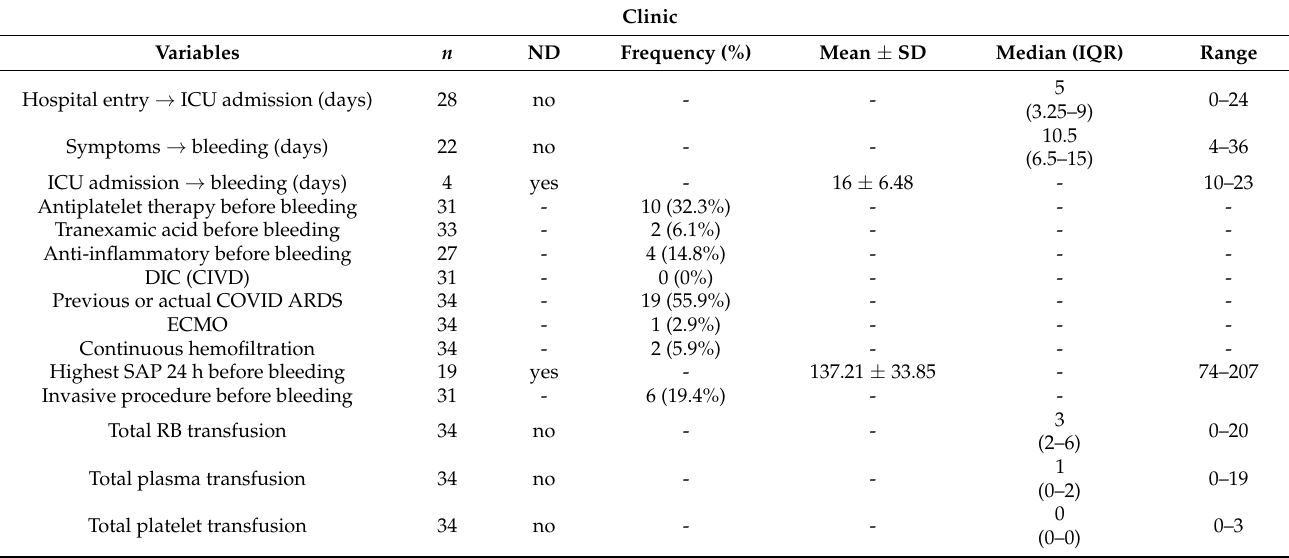
Table 3. Clinic parameters and descriptive statistics.